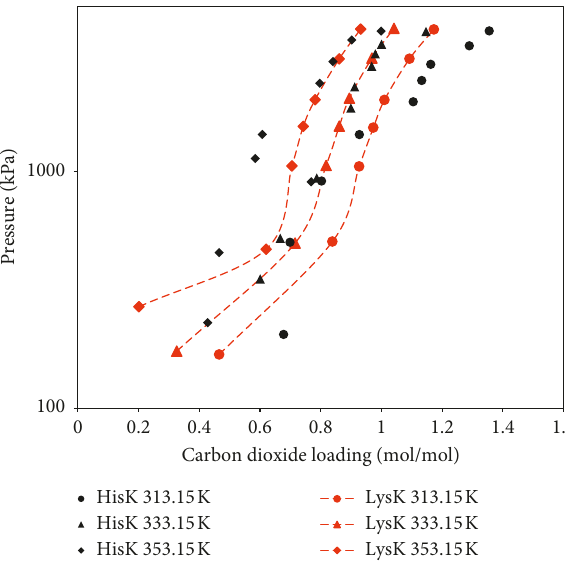
Figure 3: Experimental solubility behaviour of carbon dioxide in 2.5M aqueous potassium salt of L -histidine and data of 2.5 monoethanolamine [45].